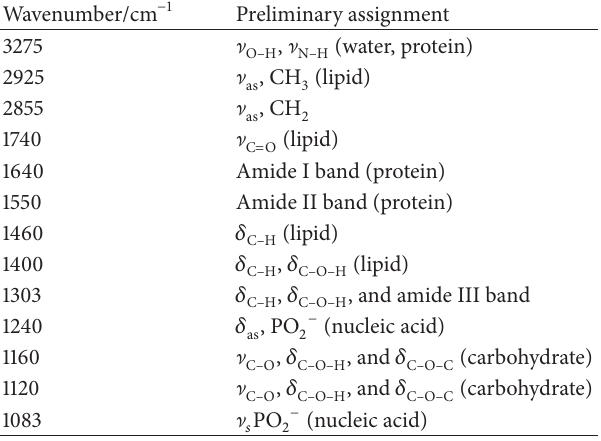
Table 1: Preliminary assignments of Fourier transform infrared bands in colorectal cancer and